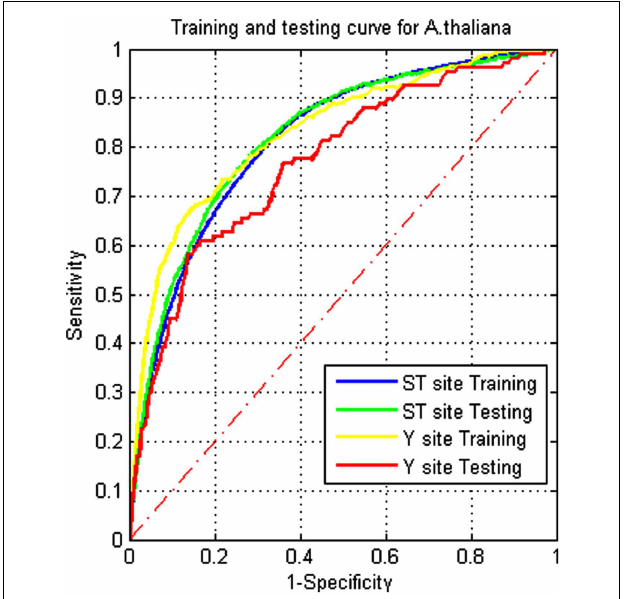
FIGURE 1 | Receiver operating characteristic curves for training and testing on Arabidopsis .